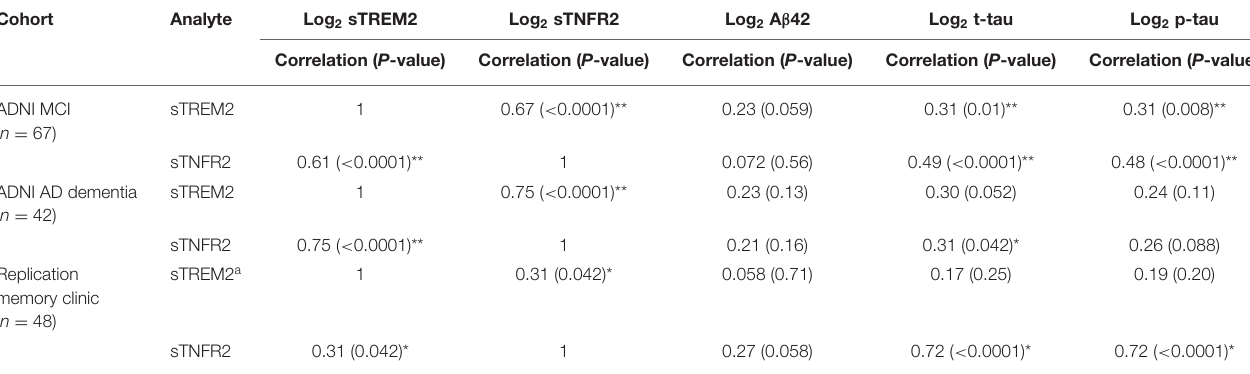
TABLE 2 | Pearson correlations between sTNFR2/sTREM2 and A β 42, t-tau, and p-tau for participants from the Alzheimer’s Disease Neuroimaging Initiative (ADNI) and replication memory clinic cohorts (participants meeting A + T + criteria, includes those with concomitant sTREM2 and sTNFR2 data). Cohort